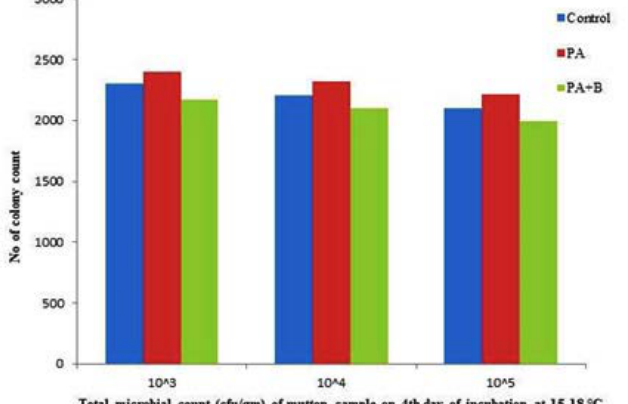
Fig. 2.8. Total microbial count of Mutton meat sample treated with strain and phage on 4 th day of Incubation at 15-18